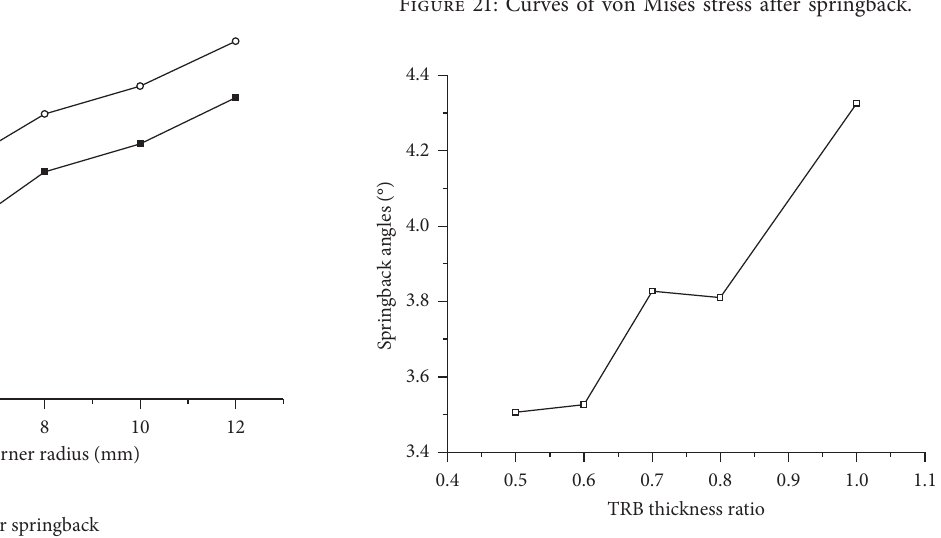
Figure 19: Curves of von Mises stress after springback.